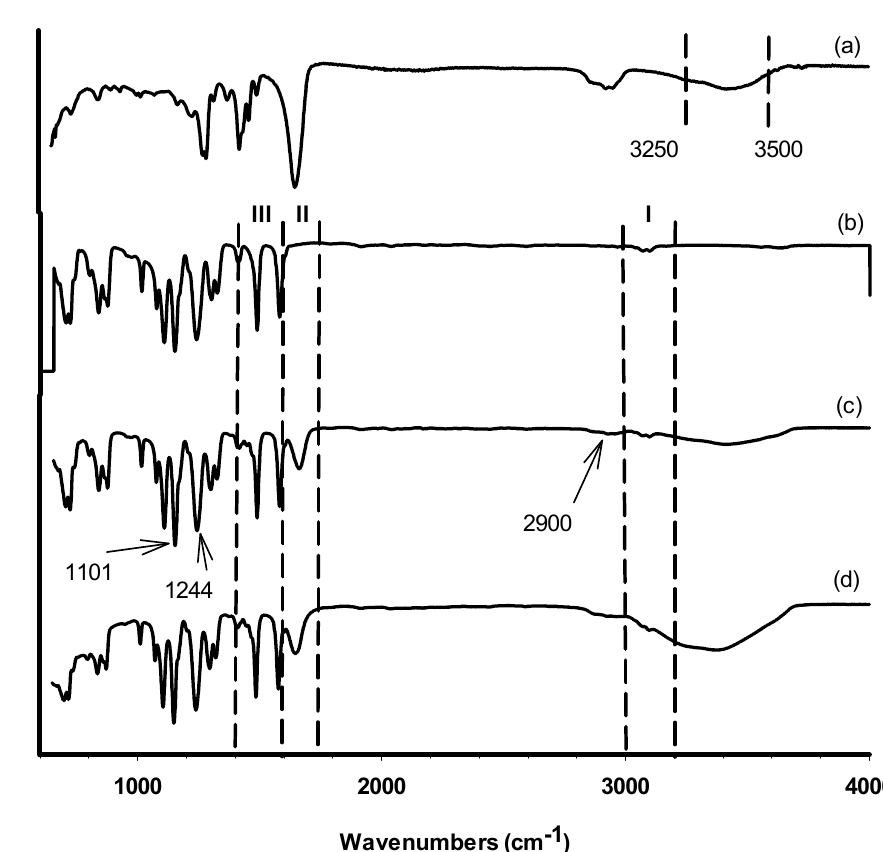
Figure 3. FTIR spectra (600–4000 cm − 1 ) of ( a ) PVP, ( b ) PES, ( c ) blank membrane, and ( d ) M3. Table 3. EDX study of the membrane